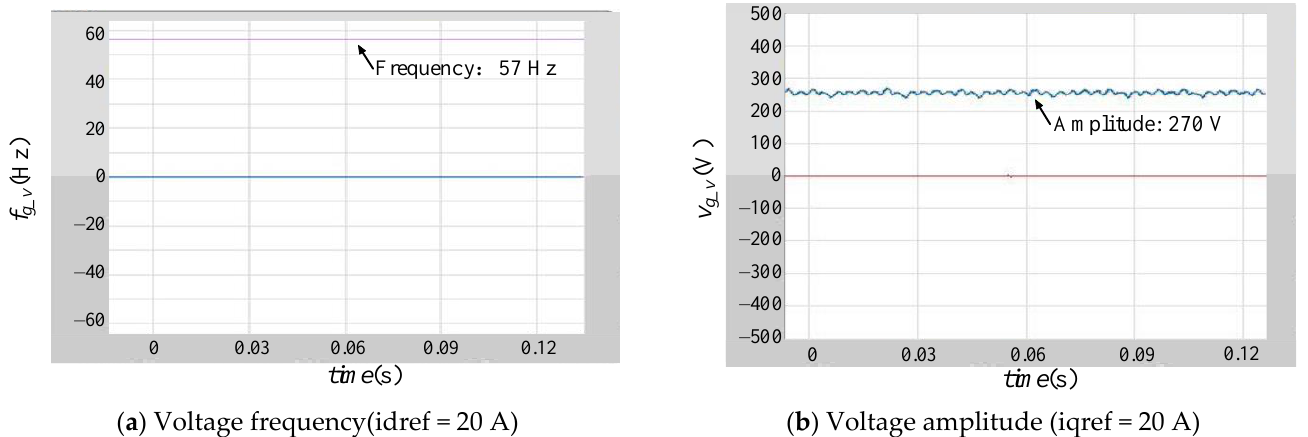
Figure 11. The frequency and amplitude of output voltage under droop control ( f 0 = 50 Hz, V 0 = 300 V). ( a ) Voltage frequency ( i dref = 20 A); ( b ) Voltage amplitude ( i qref = 20 A).